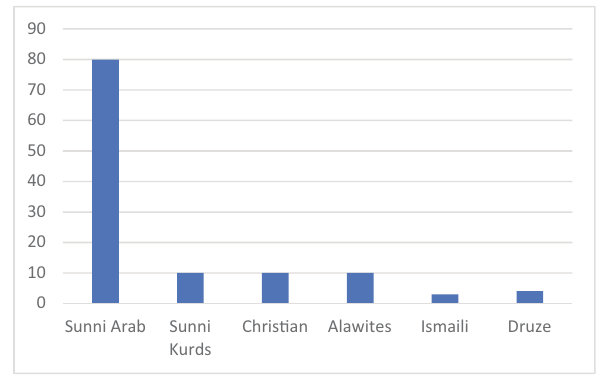
Figure 1: Religion - based ratio of Syrian